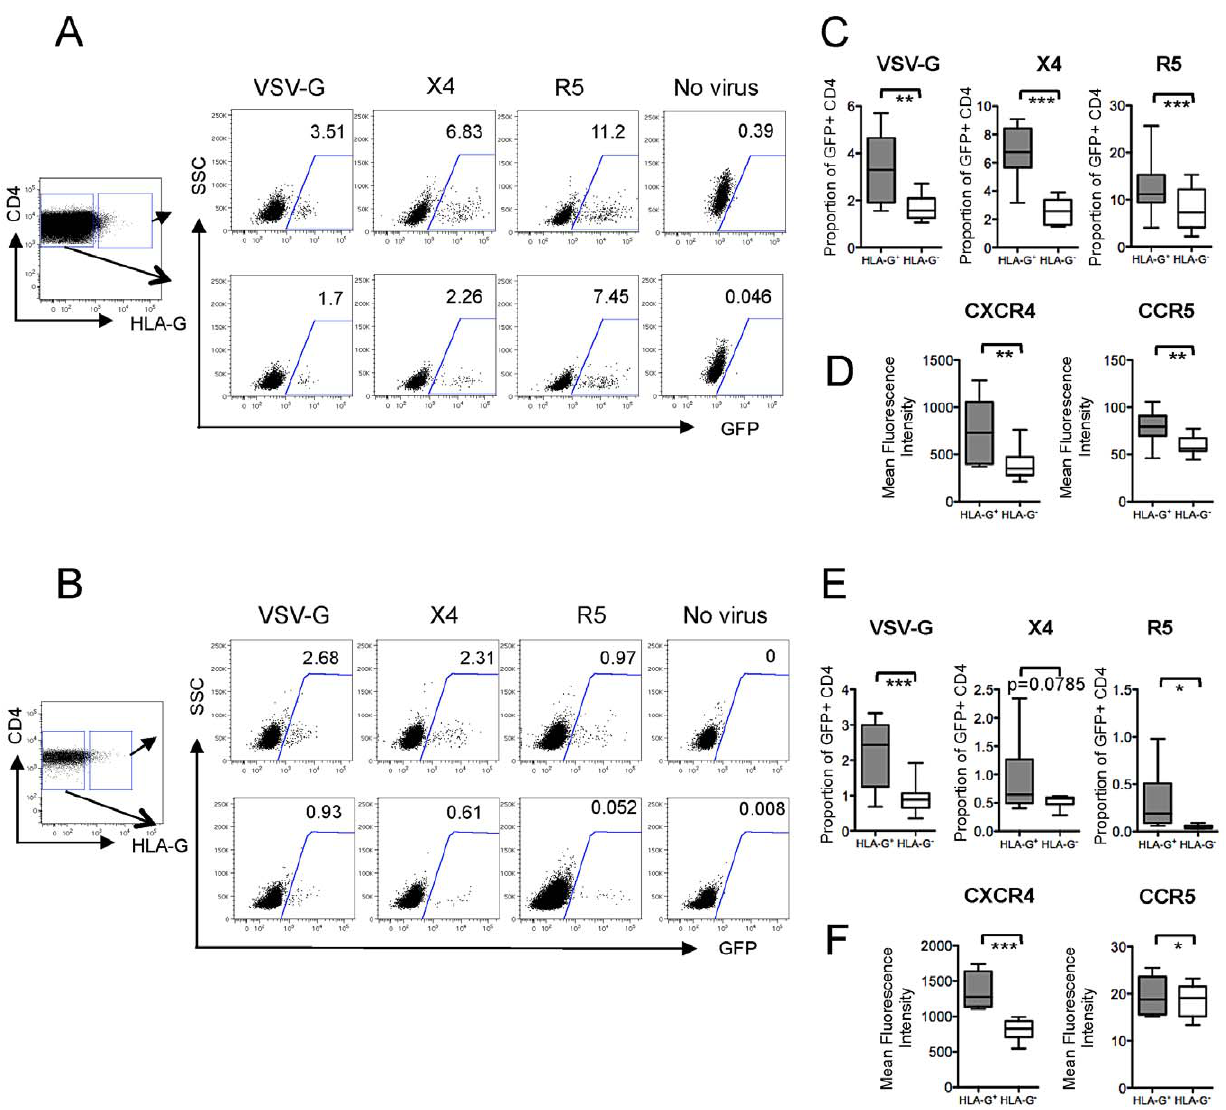
Figure 6. Susceptibility of HLA-G + Treg to HIV-1 infection. (A–B) Representative flow cytometry dot plots reflecting the proportions of GFP- expressing HLA-G + or HLA-G 2 CD4 T cells after infection with GFP-encoding X4- or R5-tropic HIV-1 viruses, or a VSV-G-pseudotyped HIV-1 vector. Cells from HIV-1 seronegative donors were infected after in vitro activation (A) or directly after ex-vivo isolation (B). (C/E) Box and Whisker plots reflecting the proportions of GFP-positive CD4 T cells after infection with indicated viral strains, with (C) or without prior in vitro activation (E). (D/F): Expression of HIV-1 co-receptors CXCR4 and CCR5 on HLA-G + or HLA-G 2 cells, with (D) or without prior ex-vivo activation (F). (C–F): Data from n=10 CD4 T cell populations with prior in vitro activation and n=9 CD4 T cell populations with direct ex-vivo infection are shown. Significance was tested by paired T test.